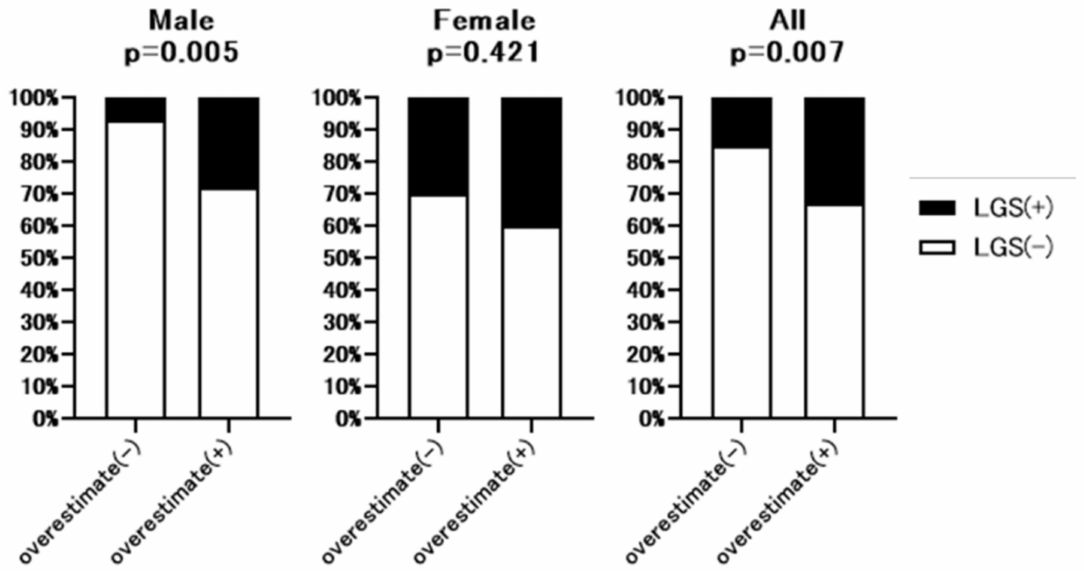
Figure 4. Comparison of the rate of low hand grip strength between patients with or without overestimated renal function. Overestimate ( − ): patients without overestimated renal function. Overestimate (+): patients with overestimated renal func- tion. LGS: Low hand grip strength. p -value indicates comparison of the Overestimate (+) group vs. Overestimate ( − )